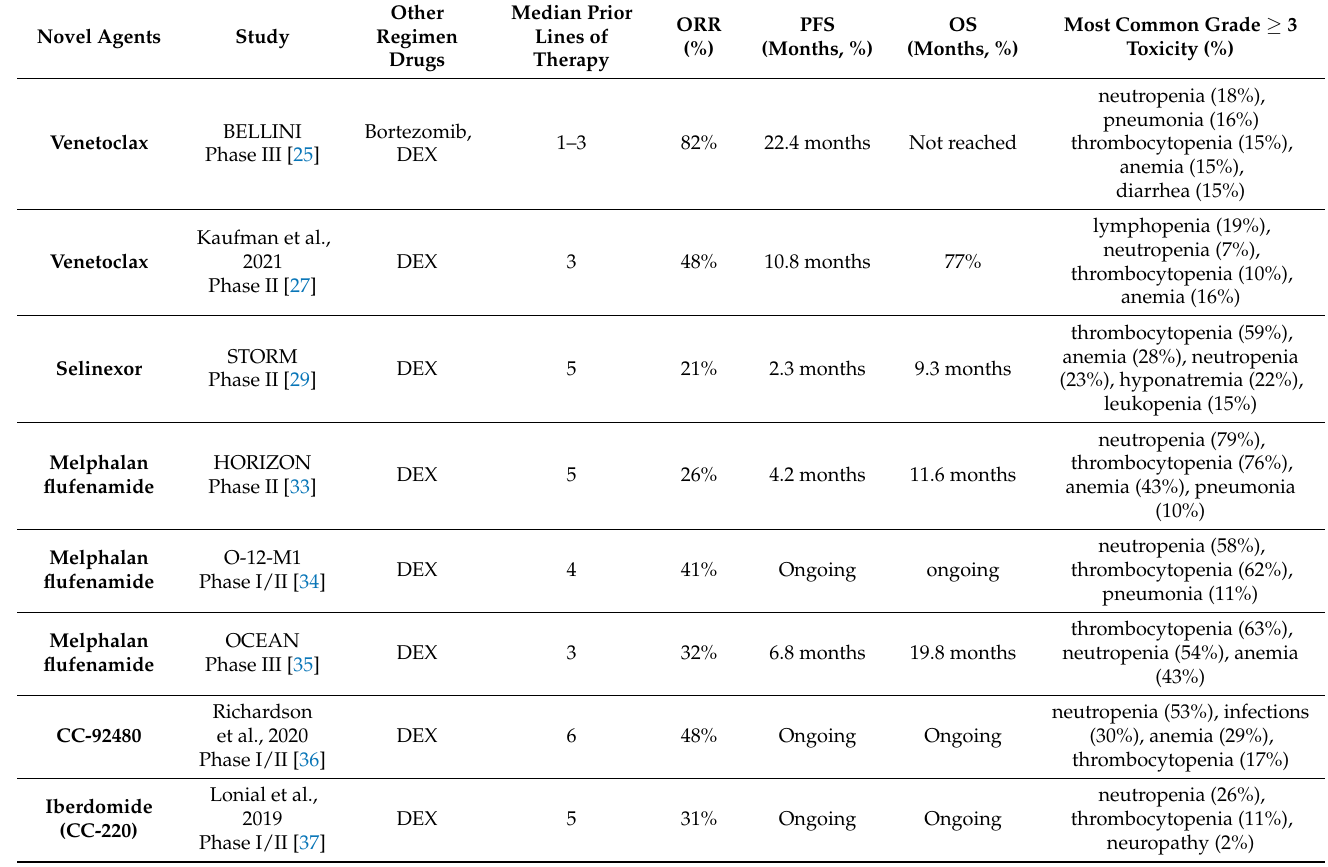
Table 2. Novel agent regimen clinical trial results in relapsed or refractory multiple